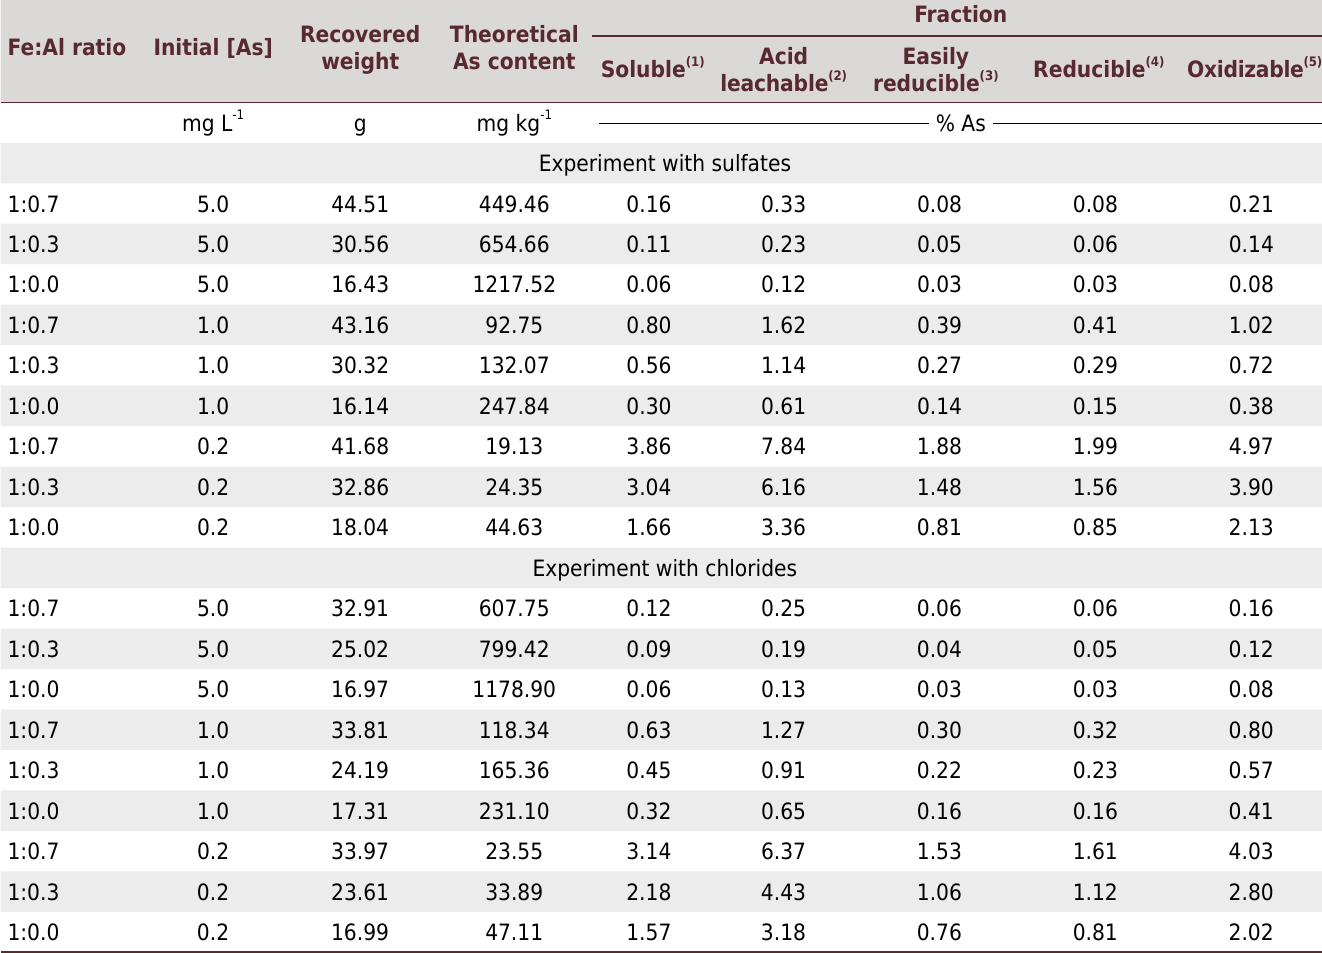
Table 8. Proportions of As (relative to theoretical total As concentrations in the precipitates) extracted by the different BCR solutions calculated from As detection limits Recovered Theoretical Fe:Al ratio Initial [As] weight As